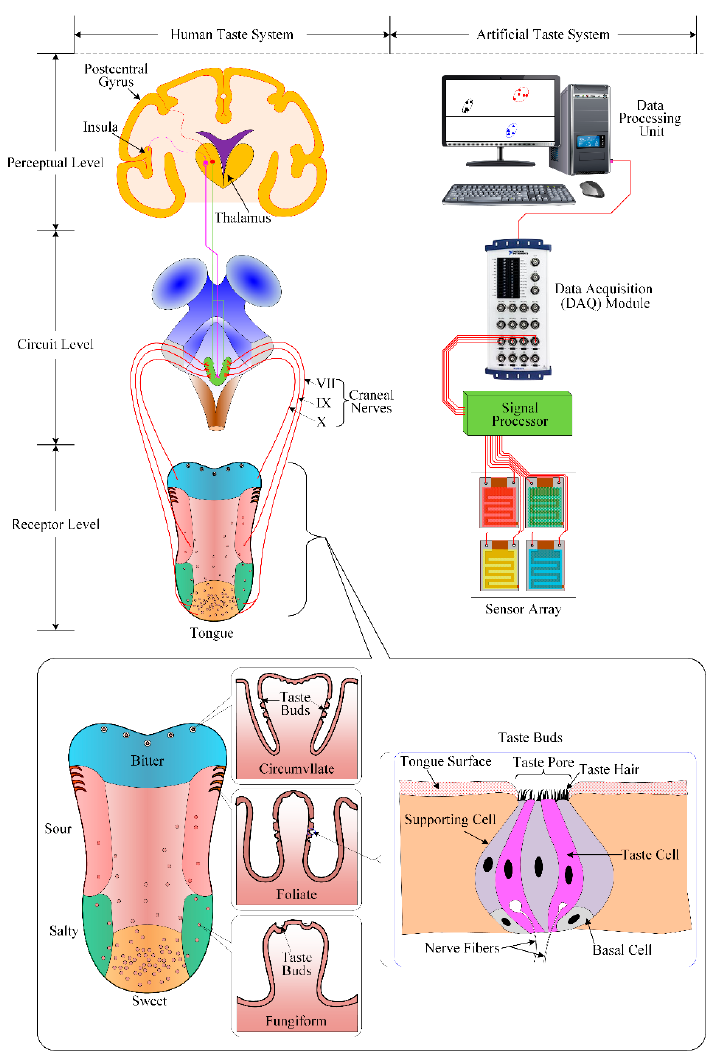
Figure 2. Functional analogy within the human (biological) taste sensing system and the electronic taste sensing system.